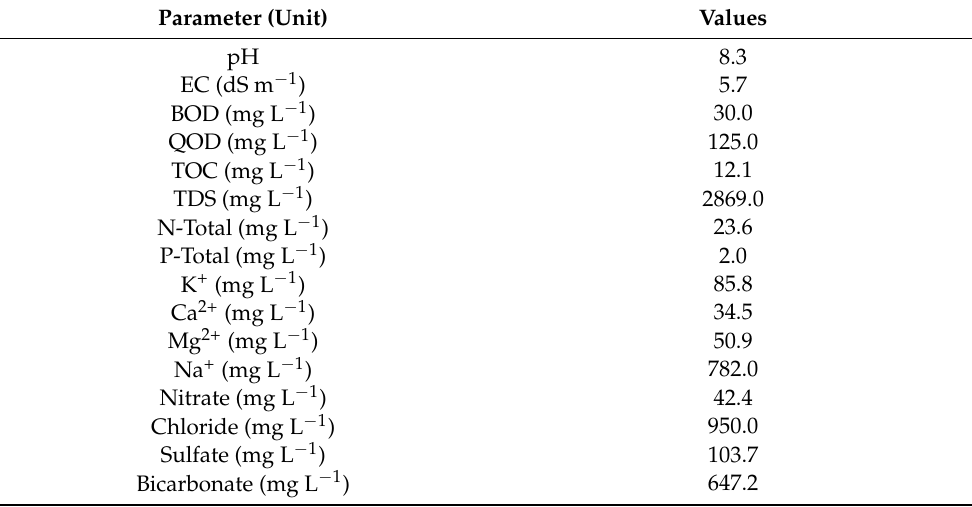
Table 2. Chemical parameters of treated wastewater used for